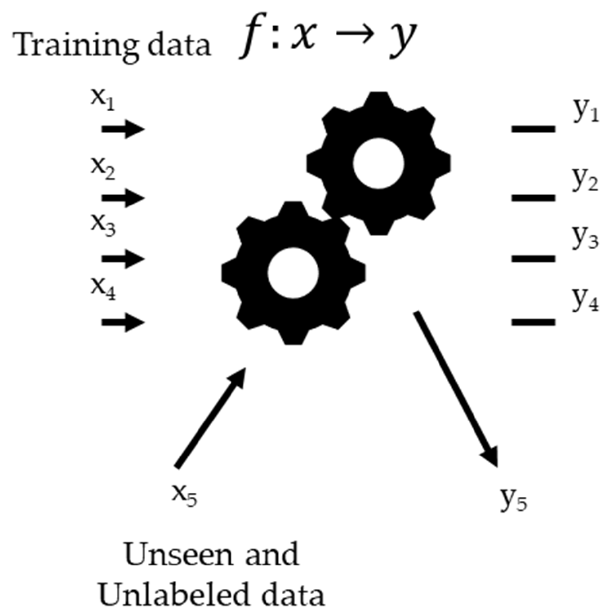
Figure 2. Scope of machine learning.